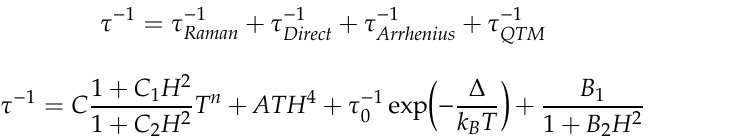
C 2 = 396(50) T − 2 , C = 88(5) s − 1 · K − 3.4 , n = 3.4(1), A = 2.9(4) × 10 5 K − 1 · T − 4 · s − 1 , τ 0 = 6.3(5) × 10 − 8 s and ∆ / k = 34(2) K; and for 4 · 3MeOH · 0.5H e ff B n = 4.8(5), A = 1.2(7) × 10 6 K − 1 · T − 4 · s − 1 , τ 0 = 5.6(5) × 10 − 11 s and ∆ e ff / k B = 39(2) K.